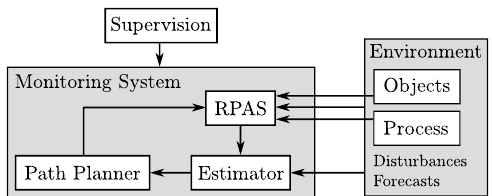
Figure 2: Key components of the monitoring systems used to solve the target tracking and dynamic coverage control